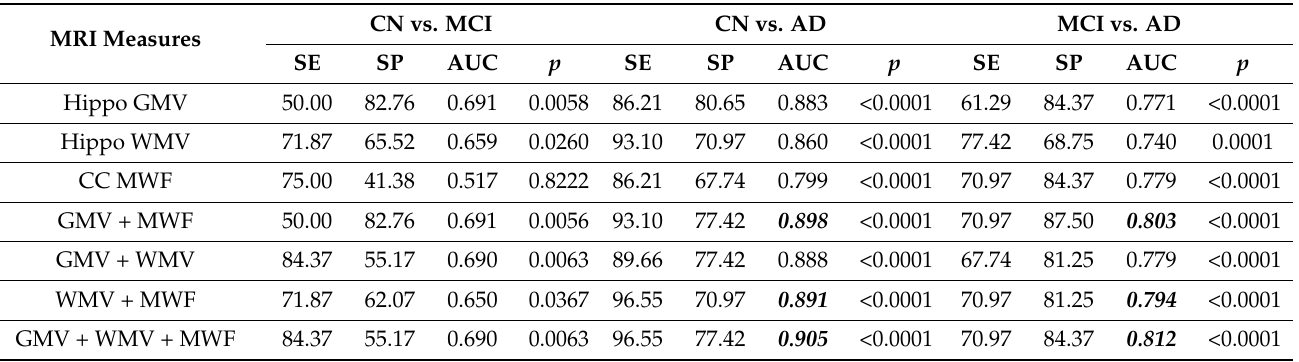
Table 4. Results of the added value analyses of MRI measures using a receiver operating characteristic (ROC) curve analysis for group